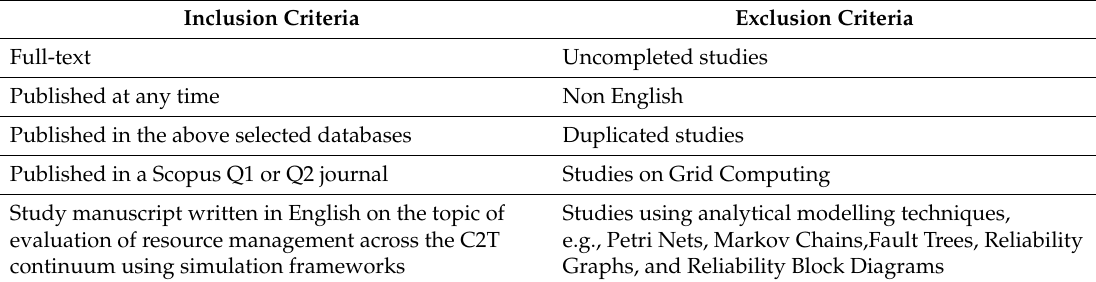
Table 1. Inclusion and Exclusion